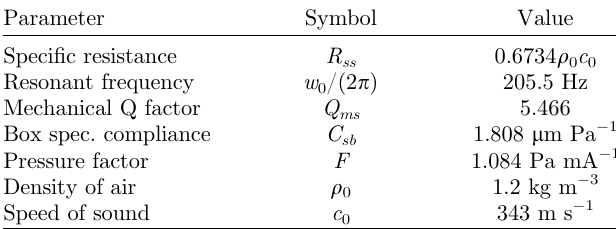
Table 3. Measured Thiele-Small parameters of the Monacor SPX-30M loudspeaker mounted on a cabinet.